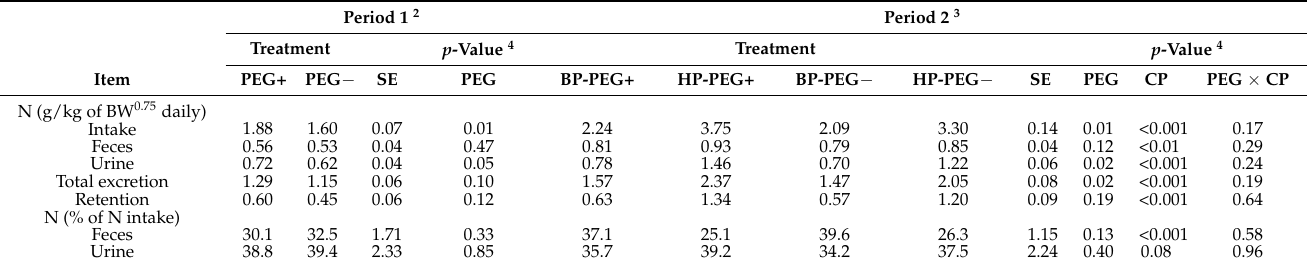
Table 3. Effect of experimental diets on the intake, digestibility, and BW in lambs in experimental periods 1 and 2 1